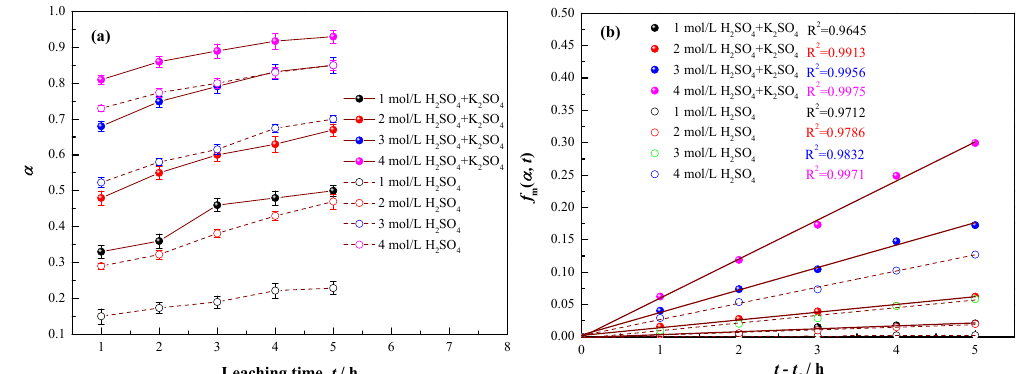
Figure 5. Variations of vanadium leaching efficiency as a function of leaching time with leaching temperature of 150 °C and K 2 SO 4 dosage of 7 wt% at acid concentrations of 1 M, 2 M, 3 M, and 4 M, respectively, ( a ) and linear-fitting curves of Equation (4), ( b ) based on the data in ( a ). The dashed lines and hollow points represent the vanadium leaching efficiency and corresponding linear-fitting curves without K 2 SO 4 addition, other leaching parameters being equal.